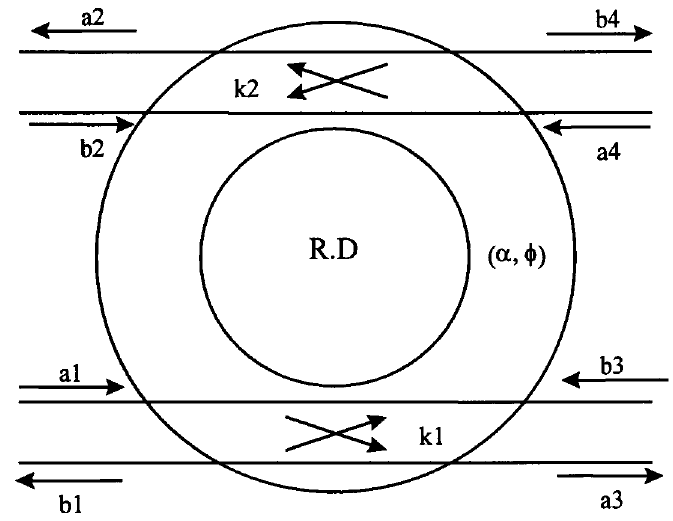
FIGURE 6 Typical schema showing the propagating way of the whispering gallery